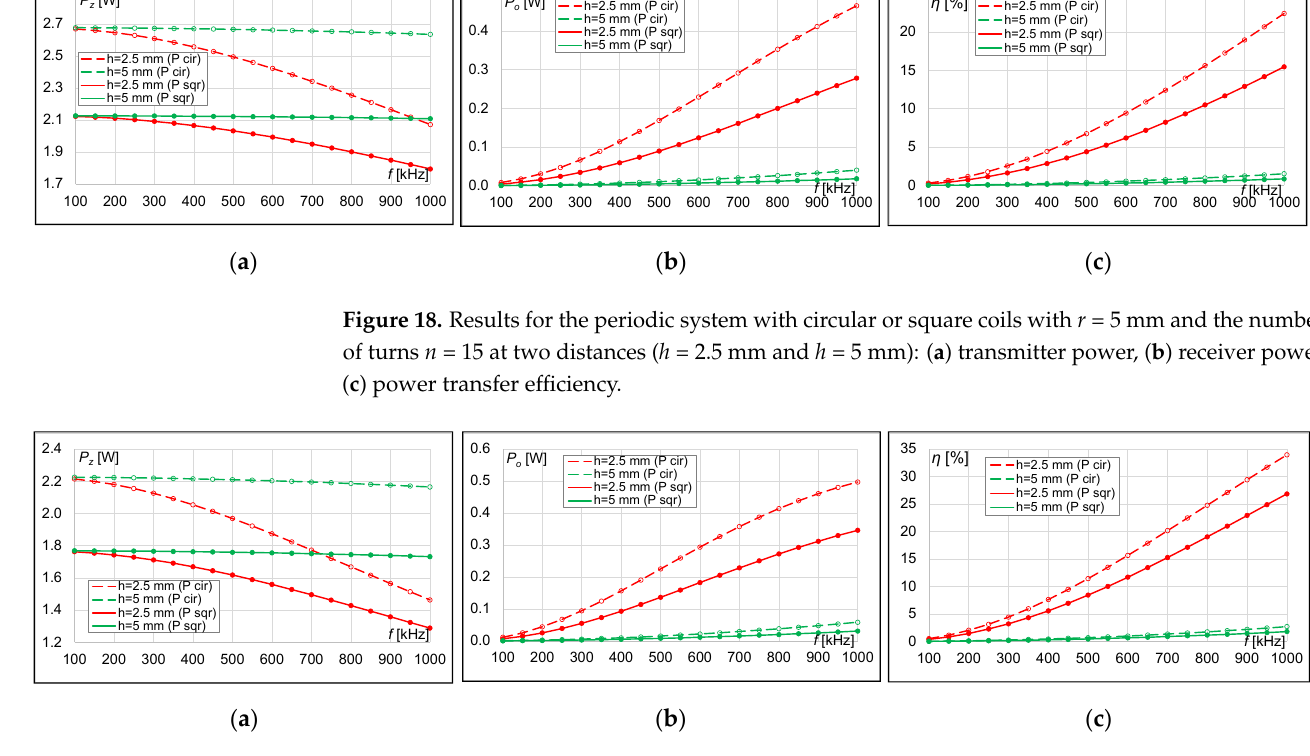
( c ) Figure 20. Results for the periodic system with circular or square coils with r = 5 mm and the number of turns n = 25 at two distances ( h = 2.5 mm and h = 5 mm): ( a ) transmitter power, ( b ) receiver power, ( c ) power transfer efficiency. Comparing periodic systems with a circular or square coil, it can be noticed that the values of the transmitter power P z rapidly decrease at a small distance between the coils, i.e., h = 2.5 mm (Figures 18a, 19a, and 20a). On the other hand, with a higher distance between the coils ( h = 5 mm), the P z values slightly decrease with increasing frequency (by a maximum of 4%). As the frequency increases, regardless of the number of turns, the power of the re- ceiver P o increases (Figures 18b, 19b, and 20b). Regardless of the distance between the coils, the higher values of power P o are for systems with a circular coil. The highest differ- ence in receiver power occurs at f = 1 MHz. The highest efficiency values are for models with a circular coil (Figures 18c, 19c, and 20c). The maximum efficiency of the system is